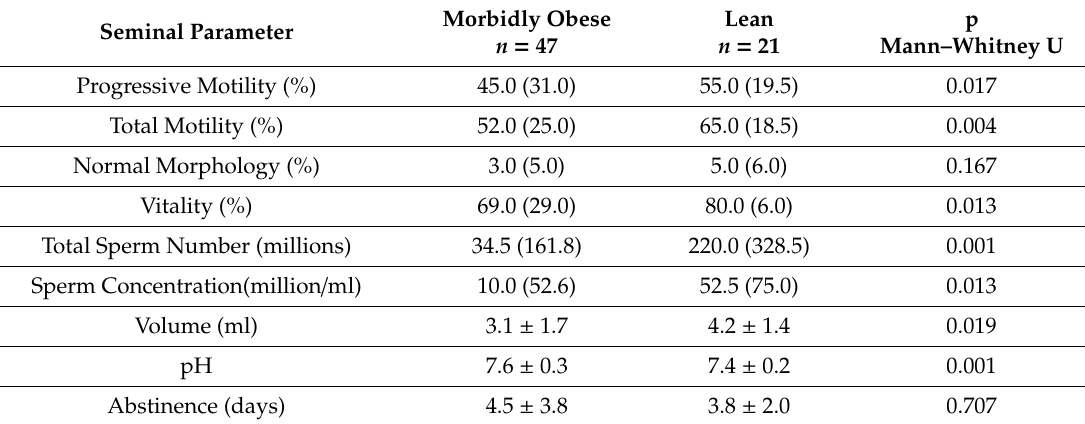
Table 3. Seminal parameters: Seminal parameters of morbidly obese and lean subjects are reported as mean ± SD for normally distributed and median (IQR) for not-normally distributed parameters and analysed with the Mann–Whitney U test for comparison between obese and lean subjects. Significant p values are indicated in italics.